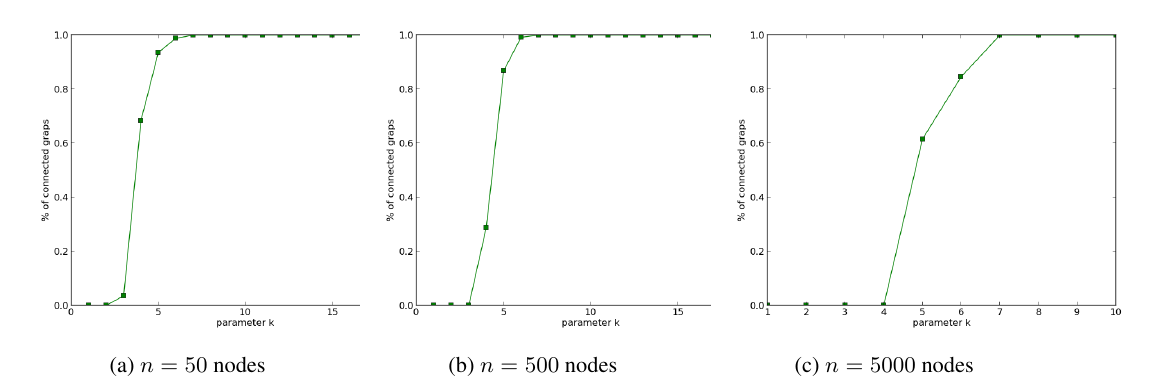
Fig. 1: Connectivity as function of parameters k network size n . In each figure the fraction of connected graphs for different k ’s is